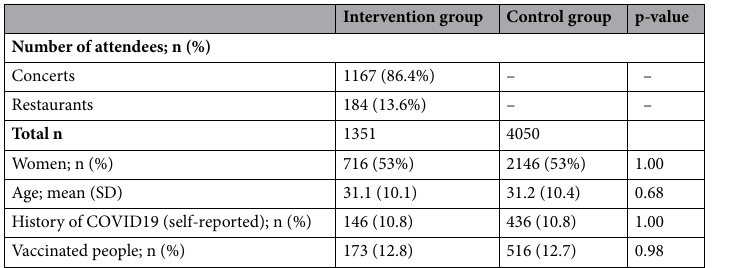
Table 1. Number of attendees by event type and participants’ characteristics at index date (1 April–21 May 2021), Catalonia, (n = 5401).